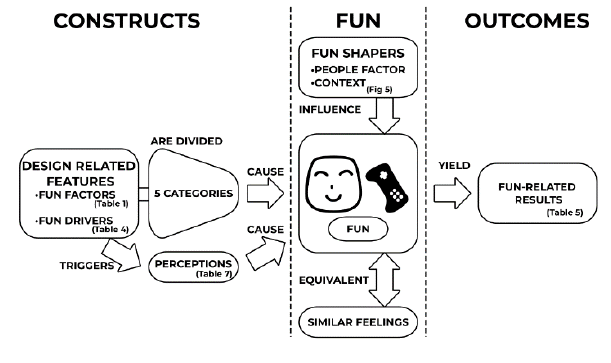
Figure 8. Fun Framework.